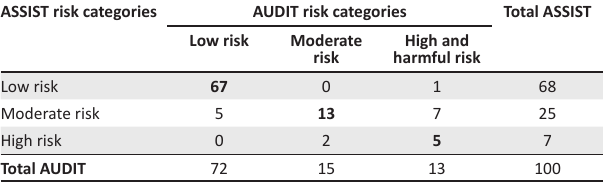
TABLE 6: Alcohol abuse risk categorisation on the Alcohol Use Disorders Identification Test versus the Alcohol, Smoking and Substance Involvement Screening Test.